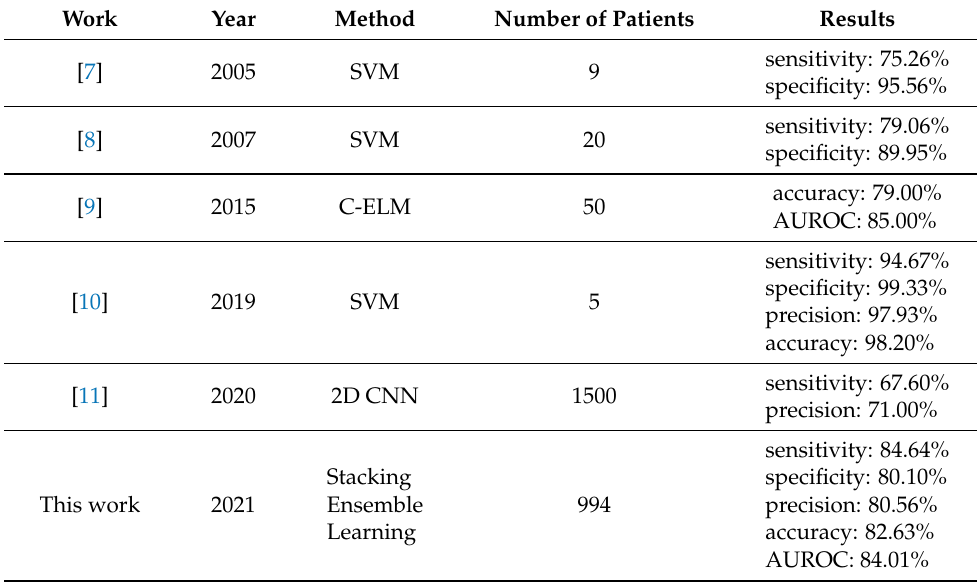
Table 7. Comparisons with state-of-the-art methods that used a single-lead EEG only.